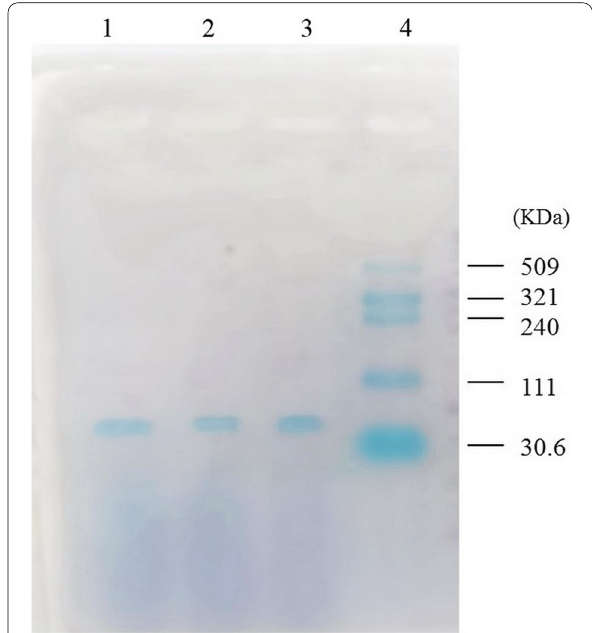
Fig. 5 Gel Analysis of obtained HA biopolymer from RBSFA, RBSTr4, and RBSTr3 using Stains-All ® method. (Lane 1: HA produced by RBSTr3, Lane 2: HA produced by RBSTr4, Lane 3: HA produced by RBSFA, and lane 4: HA